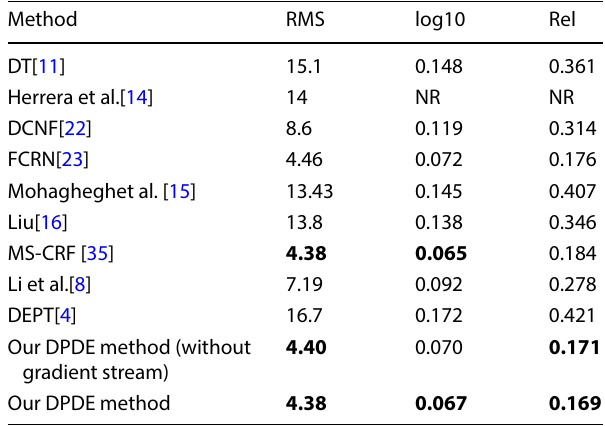
Bold indicates the best and second